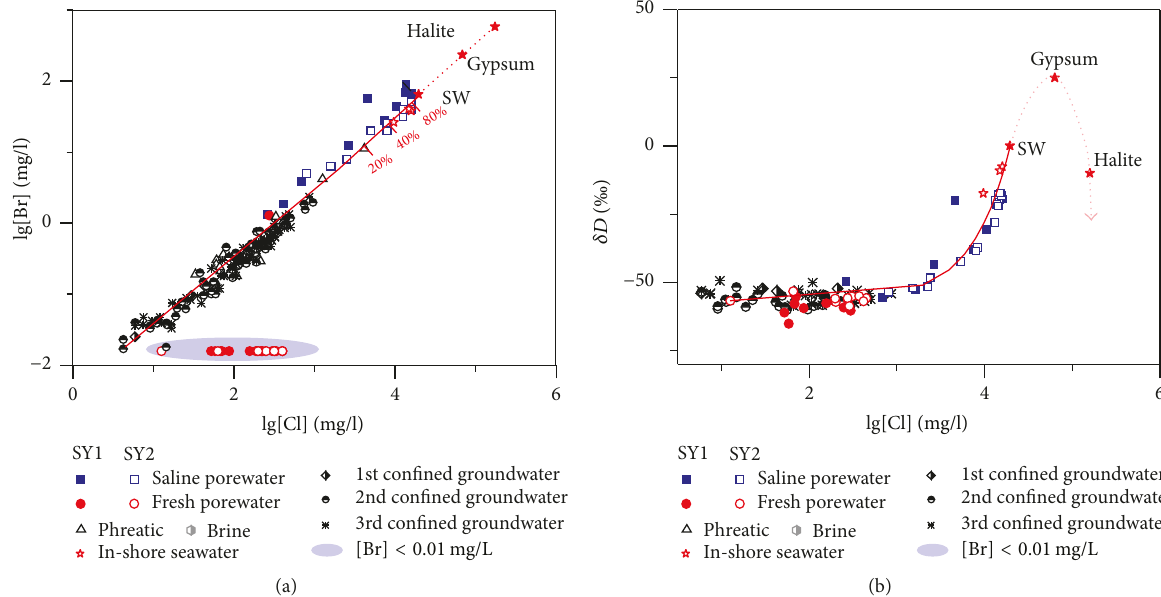
Figure 7: Cl − versus (a) Br − concentrations and (b) 𝛿 2 H of porewaters in the aquitards and groundwater in aquifers. The groundwater samples are referred from Fu [20]. The red line represents the diluted line of standard seawater (SW), and the red dotted line represents SW evaporated trajectory. The paths for evaporating seawater are from Fontes and Matray (1993)